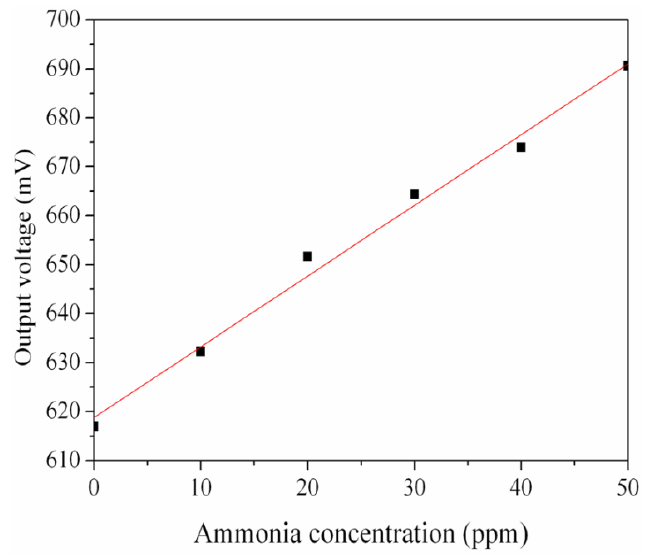
Figure 10. Measured results of the output voltage for the ammonia